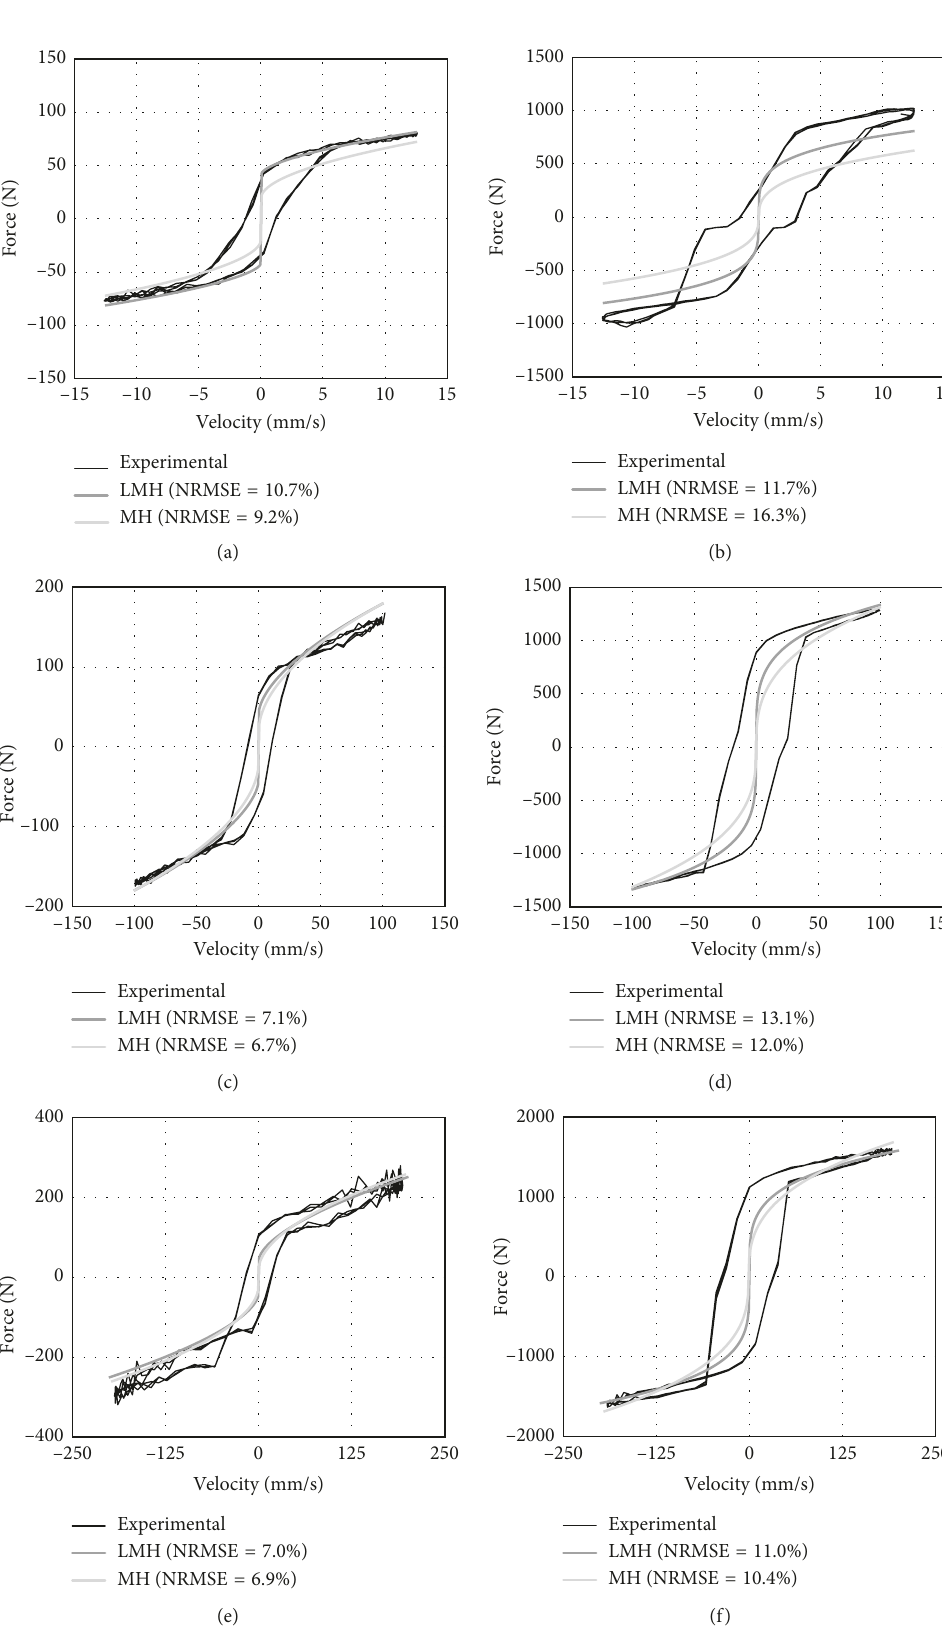
1A; (e) high velocity without intensity; (f) (cid:31)